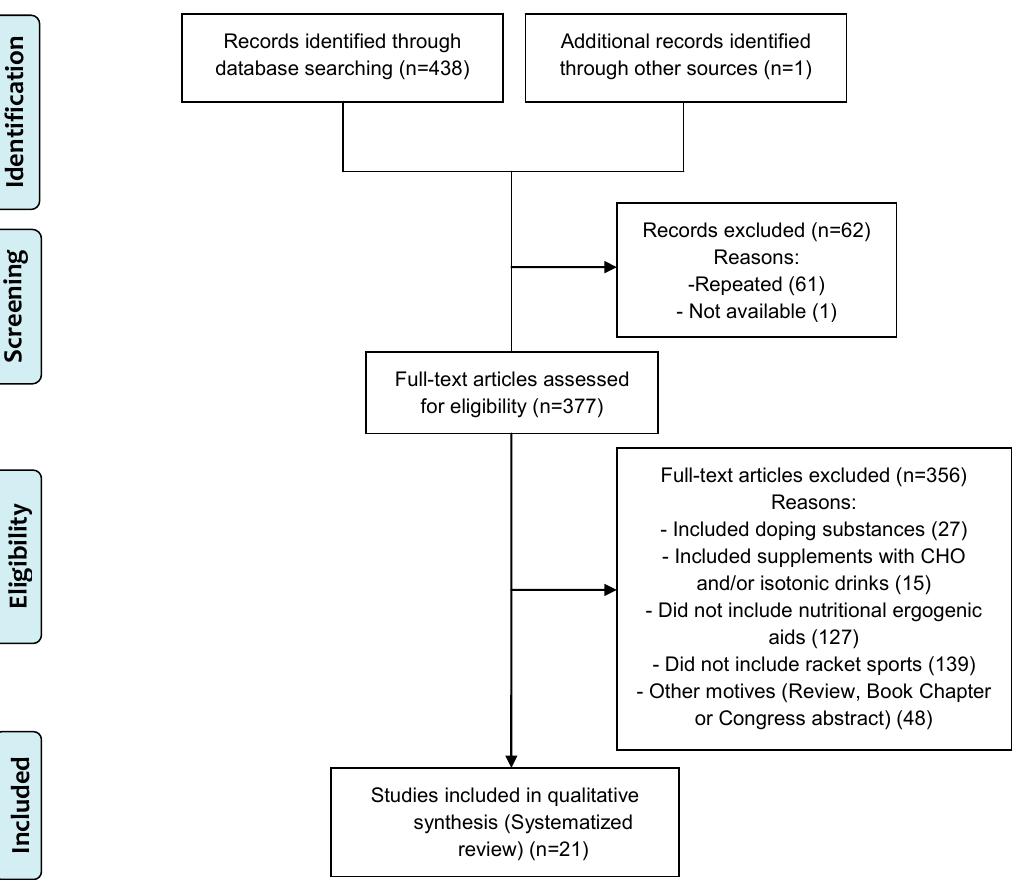
Figure 1. Preferred Reporting Items for Systematic Reviews and Meta-Analyses (PRISMA) flow chart [21] of the study selection process.